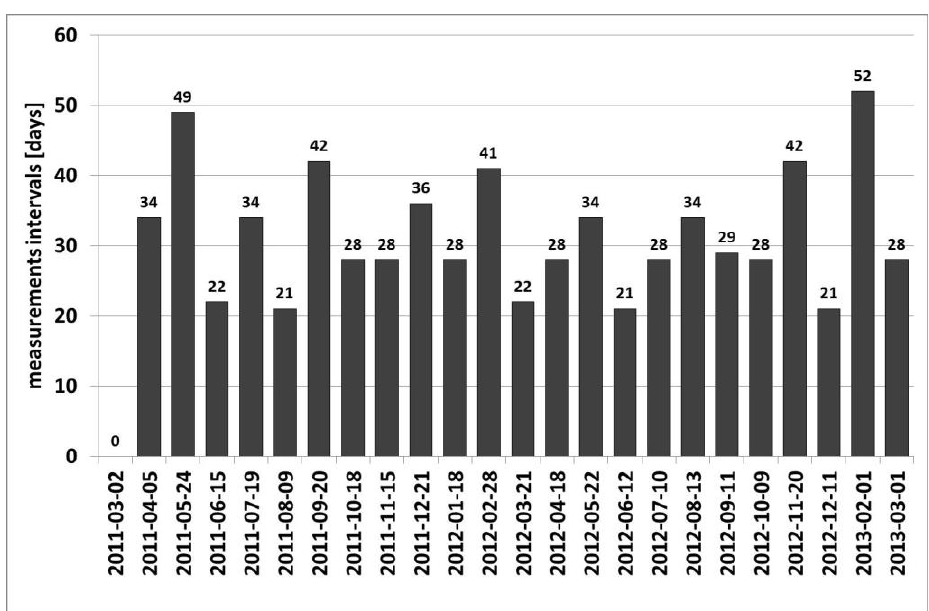
Fig. 2. Time intervals between the